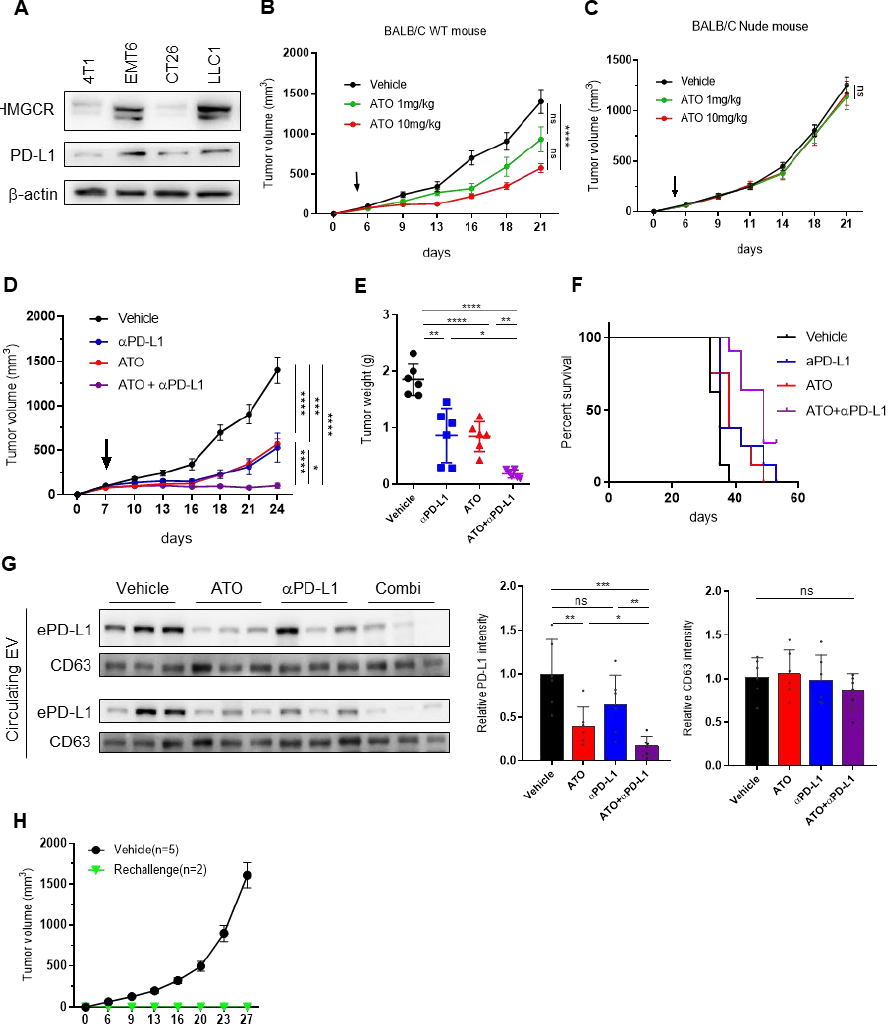
Figure 4. ATO treatment improves the efficacy of anti-PD-L1 immunotherapy. ( A ) Immunoblot for HMG-CoA reductase (HMGCR) and PD-L1 from mouse cancer cell lines. β -actin was used as a loading control for whole-cell lysates. EMT6 cells were subcutaneously inoculated into BALB/c ( B ) nude or ( C ) wild-type (WT) mice ( n = 6). The arrows indicate the beginning of ATO administration (at tumor volume = 50 – 100 mm 3 ). ( D ) Tumor mass of BALB/C WT mice implanted with EMT6 cells and treated with vehicle or ATO 10 mg/kg and anti-PD-L1 ( n = 6). ( E ) Tumor weight of BALB/C WT mice implanted with EMT6 cells. ( F ) Survival analysis of BALB/C WT mice with different treatments ( n = 6). ( G ) Immunoblots of PD-L1 of the circulating EVs and cellular PD-L1 in tumors treated with or without ATO. Quantitative analysis of relative protein expression ( n = 6). ( H ) Changes in tumor volumes after tumor rechallenge in the EMT6 models. The results are presented as mean ± S.D. of three independent experiments. * p < 0.05, ** p < 0.005, *** p < 0.001, and **** p < 0.0001; NS, not significant.